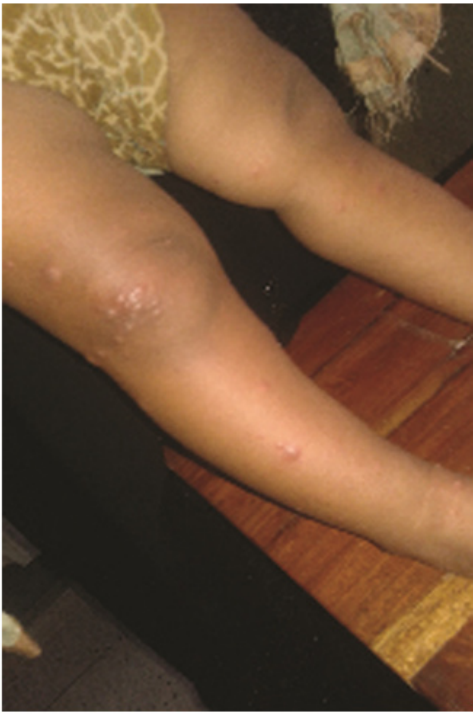
Figure 1. Multiple vesicular lesions containing turbid fluid seen in right knee of 4-year old girl.